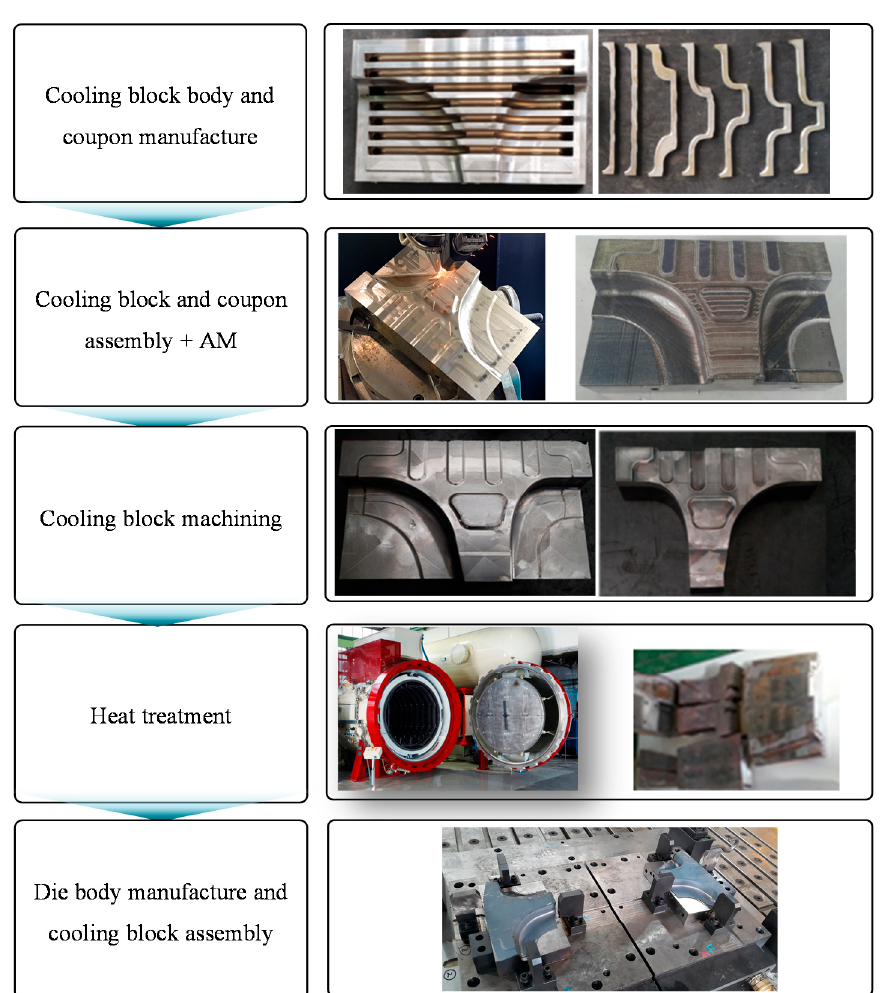
Figure 13. The overall process of fabricating a hot-stamping die with a conformal cooling channel.